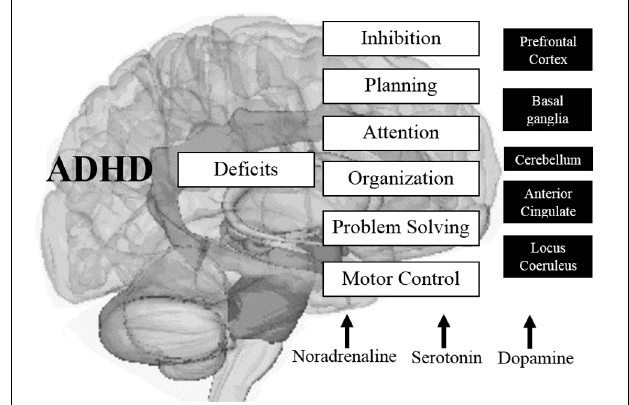
FIGURE 3 | Main altered brain structures in ADHD and their effects on cognitive components associated with EFs. Source: made by